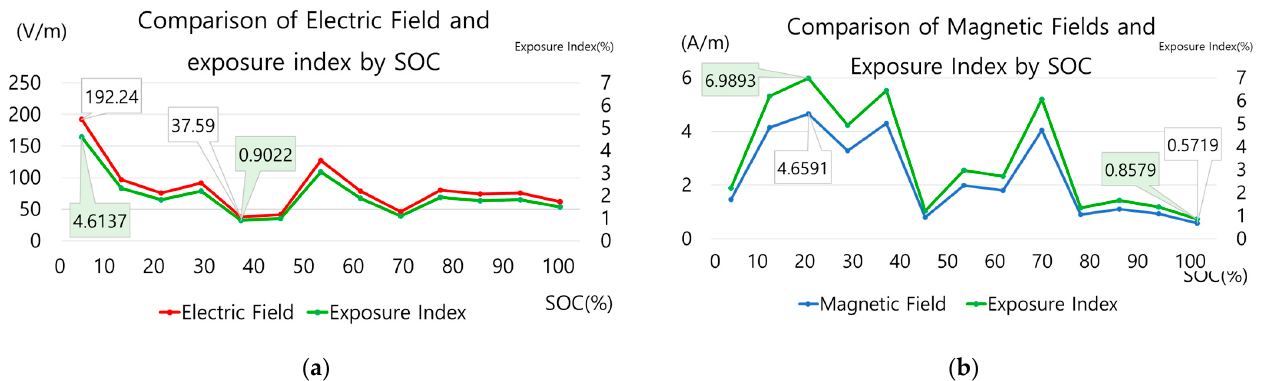
Figure 8. Electromagnetic field characteristics of standard stand B cable SoC change: ( a ) comparison of electric field measurement and exposure index; ( b ) magnetic field measurement and exposure index comparison.